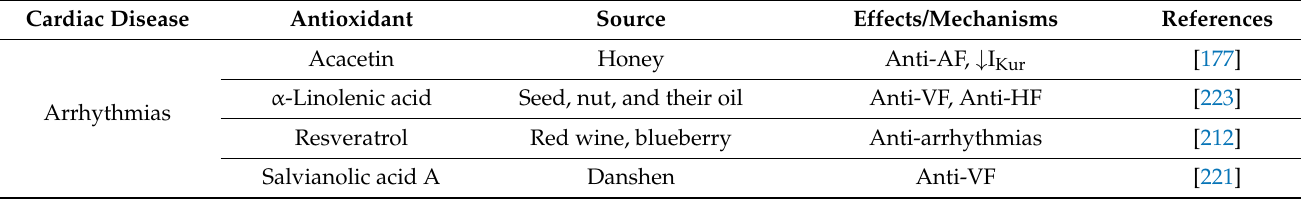
Table 1. Exogenous natural antioxidants to modulate cardiac function and pathogenesis. Cardiac